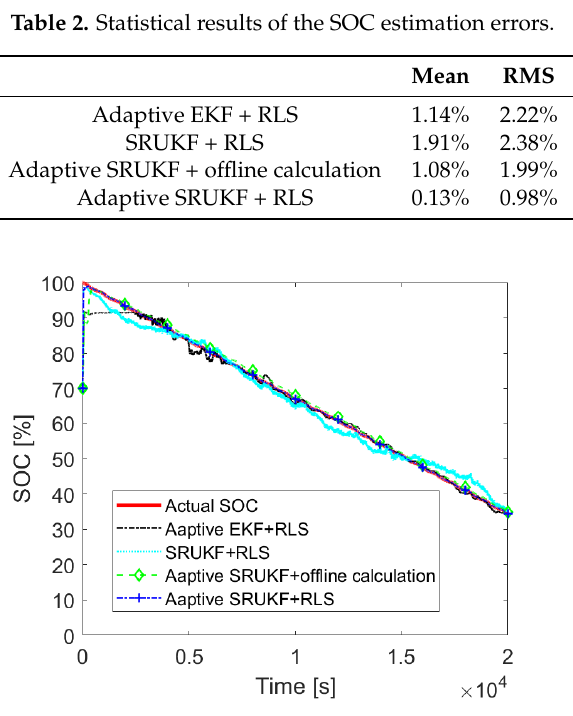
Figure 9. Actual and estimated SOC curves.